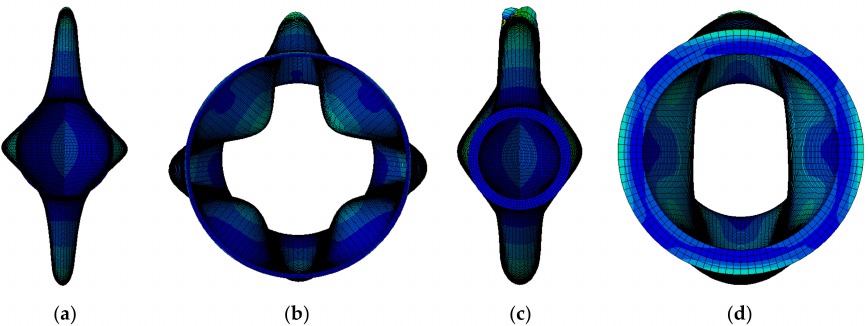
Figure 5. Buckling modes for modle 5~8 (Clamped support) ( a ) Model 5; ( b ) Model 6; ( c ) Model 7; ( d ) Model 8.